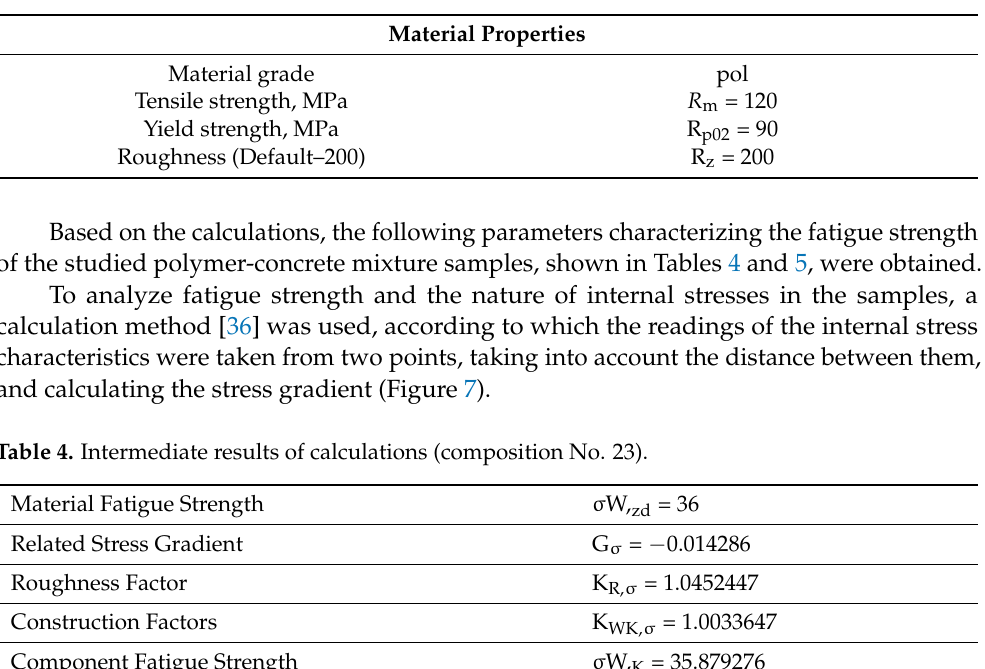
Figure 6. The results of the V0 static analysis (polymer concrete No. 23).